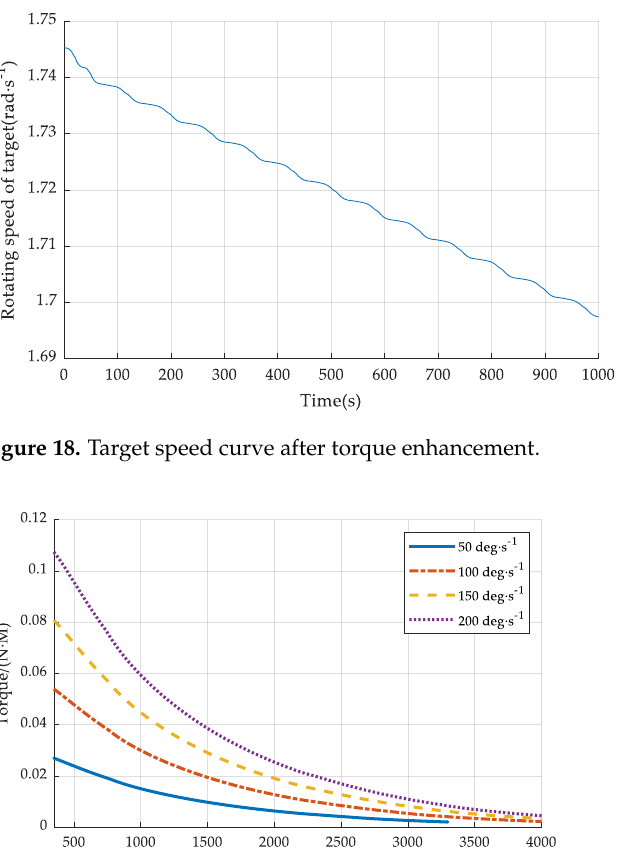
Figure 17. Enhanced eddy current torque curve.